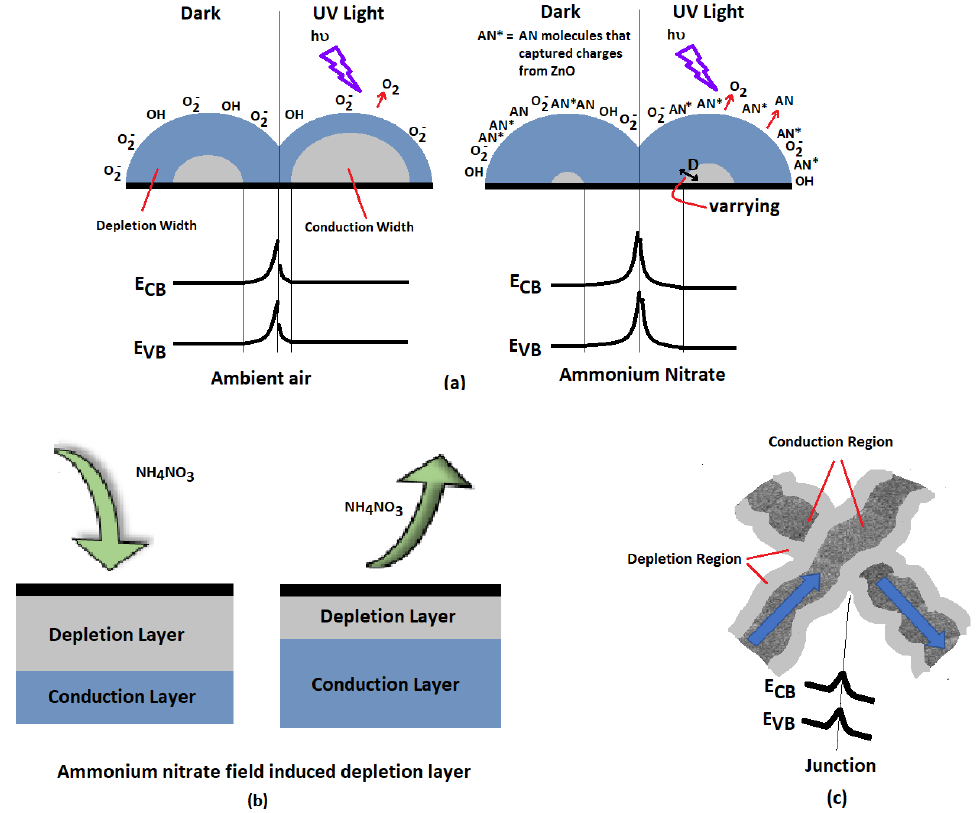
Figure 4. Schematics of the ammonium nitrate detection mechanism. ( a ) Left: Absorption/desorption of ambient air. Right: Adsorption/desorption of ammonium nitrate. The oxidizing component of ammonium nitrate captures electrons, thereby increasing the width of the depletion layer. The width, D, of the depletion layer with AN exposure can either decrease, increase or stay the same with UV illumination in comparison to dark conditions. The critical width of the depletion layer for achieving optimal response depends on the materials and operational parameters. ( b ) The dipole field of AN causes a redistribution of charges near the ZnO surface, and thus affect the width of depletion layer. ( c ) The junction of nanospring networks develops a potential barrier with AN vapor exposure. The blue arrows show the direction of the electronic conduction.